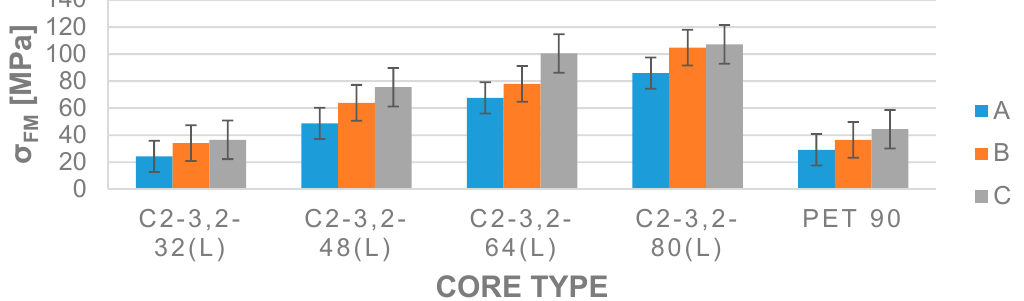
Figure 5. Influence of A–C coatings on the strength of the sandwich constructions. Core used: C2 honeycomb with unified mesh size of 3.2 mm and various densities (32, 48, 64, 80) kg·m − 3 , orientation: L and PET foam (80 kg·m − 3 ).